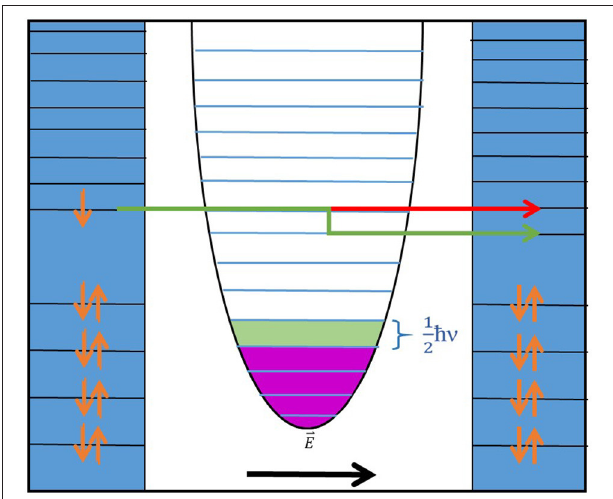
FIGURE 1 | A schematic representation of the electron-donor(left)-acceptor (right) system as is of concerning in IET. A full description is discussed within the main